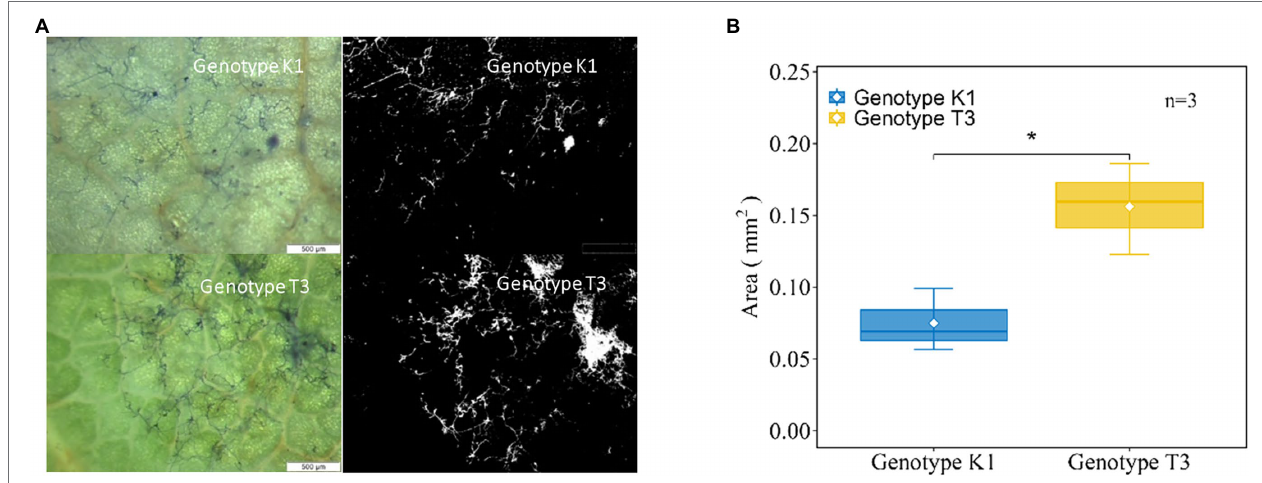
FIGURE 3 | (A) Microscopic (left) and binary image (right) of the hyphal growth at 24 h post inoculation (hpi) for Kreuzkogel 1 (K1) and Tenno 3 (T3). The microscopic evaluation was done by trypan blue staining of fungal growth and the binary image was converted and analyzed by the ImageJ software. (B) Total area (mm 2 ) of hyphae on leaves of K1 and T3 at 24 hpi. The asterisk ‘ * ’ indicates significant difference among two genotypes by Wilcox test at p < 0.05.